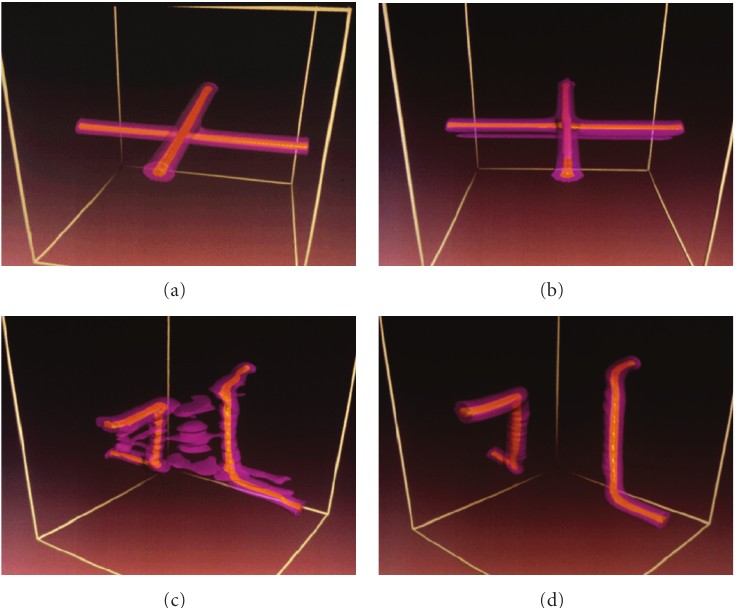
Figure 4: Numerical simulations of the intersection between two Abelian Higgs strings [154]. The Higgs and gauge field profiles are represented as the inner orange and outer pink tubes. Generically, Abelian Higgs strings with m h > m b